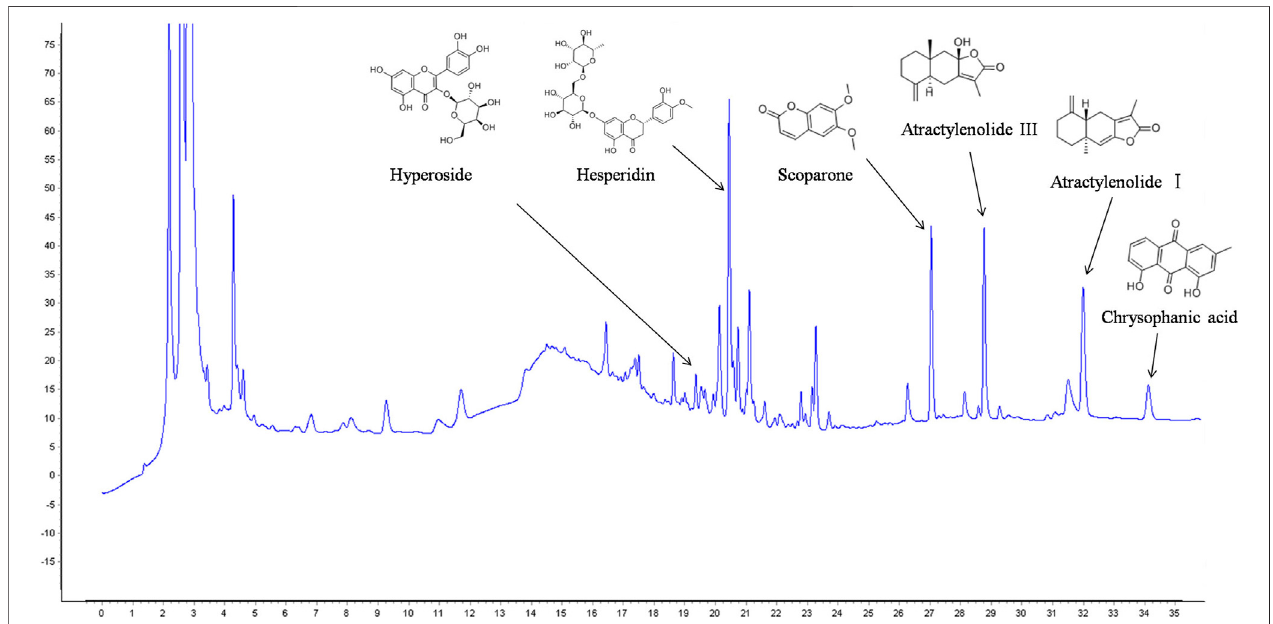
FIGURE 3 | HPLC analysis of main components in